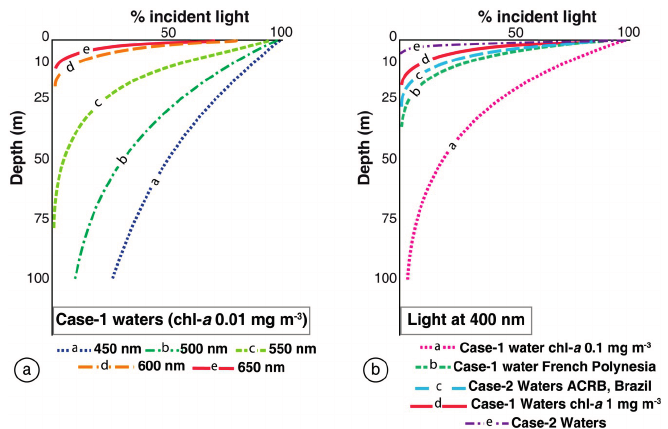
Figure 1. Light decay modeled along water column expressed as percentage of incident light as function of depth (m). ( a ) Curves represent different wavelengths (nm) in an environment considered as Case-1 water, where chl- a concentration is 0.01 mg·m − 3 ; ( b ) All curves represent light at 400nm but in different kind of environment: Case-1 waters (chl- a = 0.1 mg·m − 3 ); French Polynesia Case-1 waters ( (cid:1837) Abrolhos Coral Reef Bank (ACRB), Brazil ( (cid:1837) (chl- a = 1 mg·m − 3 ); Case-2 waters (chl- a= 0.5 mg·m − 3 , (cid:1853) concentration = 0.5 g·m − 3